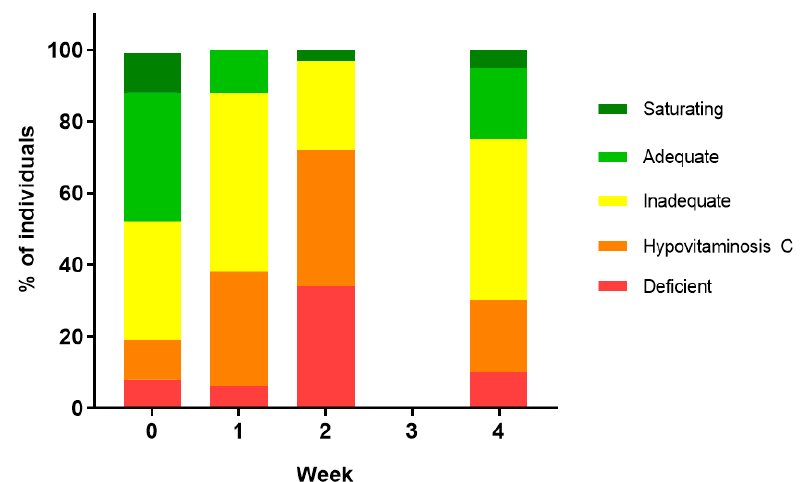
Figure 2. Percentage of individuals in different vitamin C categories. Vitamin C categories are